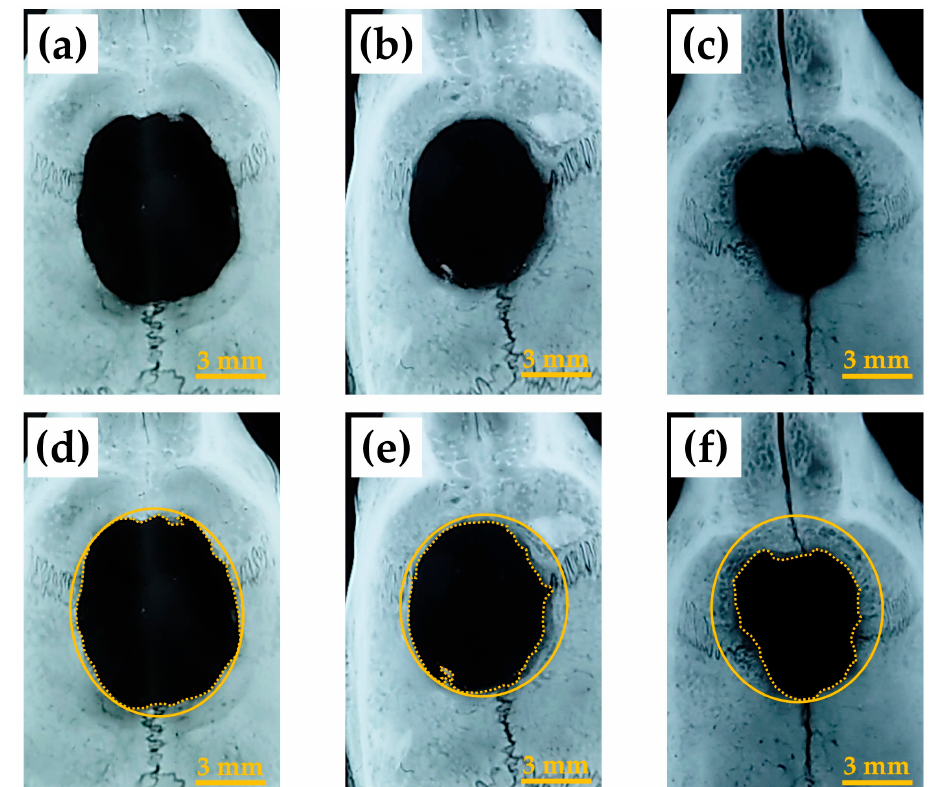
Figure 7. Representative soft X-ray image of rat cranial bone defects 8 weeks after the operation with and without construct materials including ( a ) defects only, ( b ) defects with BMP ( − ) construct (i.e., cHLA/cAG/nHAp) and ( c ) defects with BMP (+) construct (i.e., cHLA/cAG/nHAp/BMP); ( d ) same defect of ( a ) with two circles added, ( e ) that of ( b ), ( f ) that of ( c ). Note: In ( d – f ), solid line circles corresponded to the original defect while broken line circles indicated the edge of extending bone from defect peripheries.